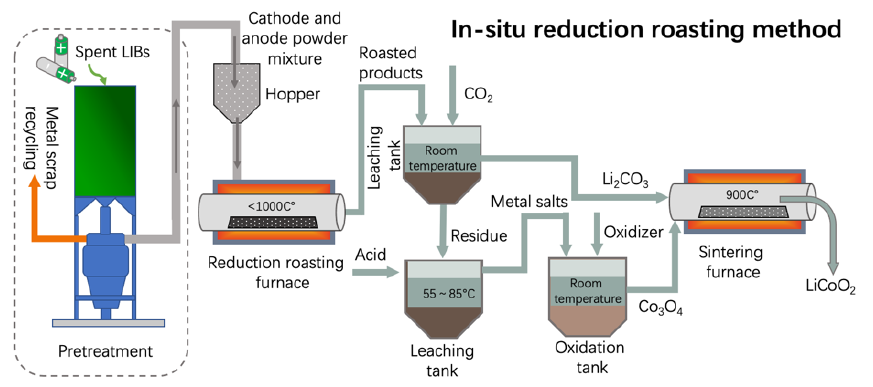
Figure 3. Schematic of the In-situ reduction roasting method of spent LIB recycling system.